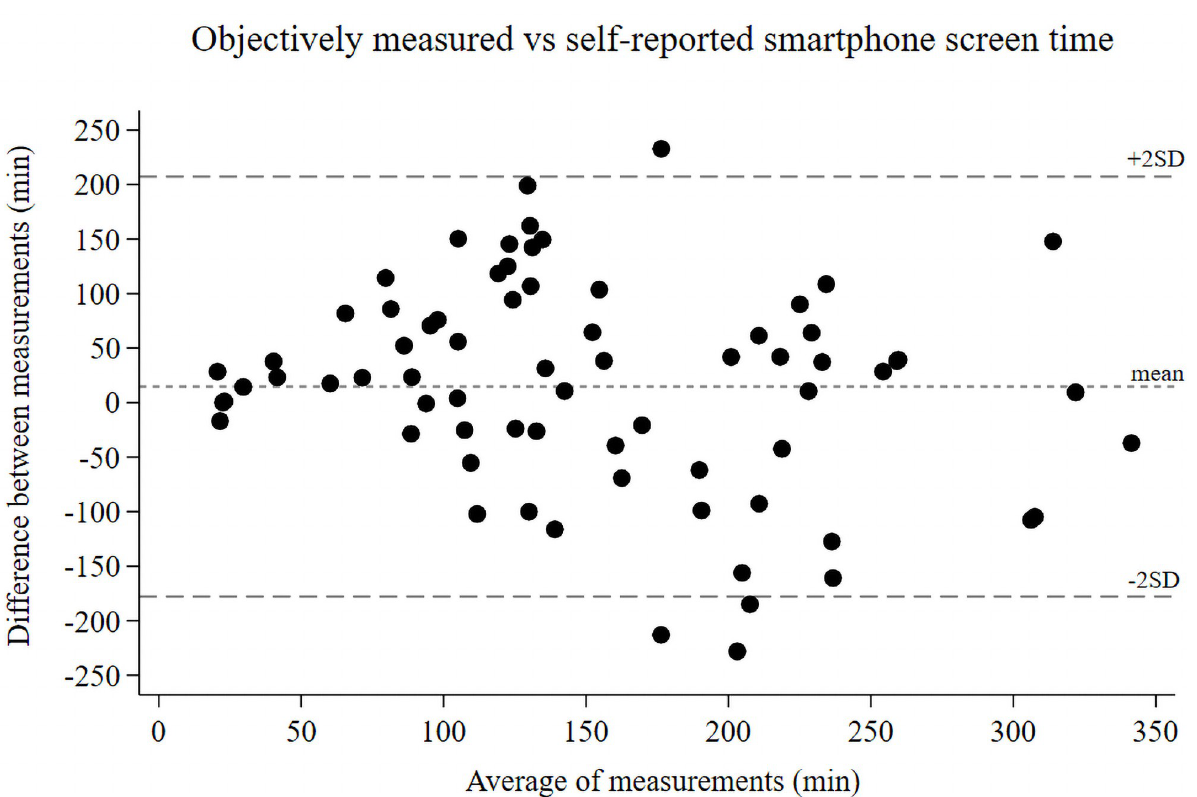
Fig 1. Bland-Altman plot. Comparing smartphone screen time measured with SCRIIN application and smartphone/tablet screen time from questionnaire.